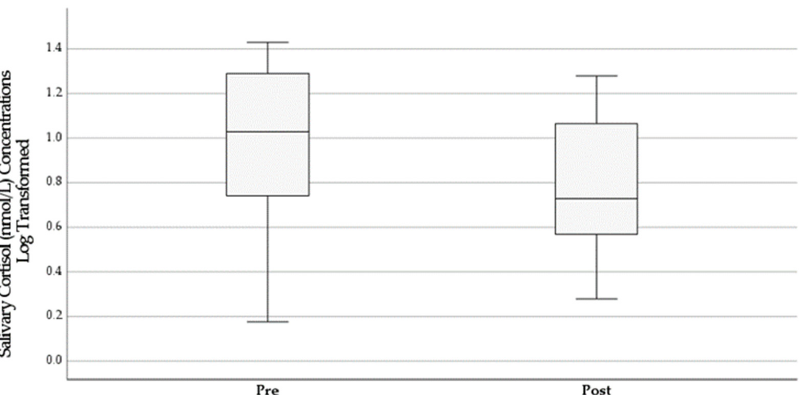
Figure A2. Box plot showing changes in the mean salivary cortisol concentrations for beaver harvesting activities.